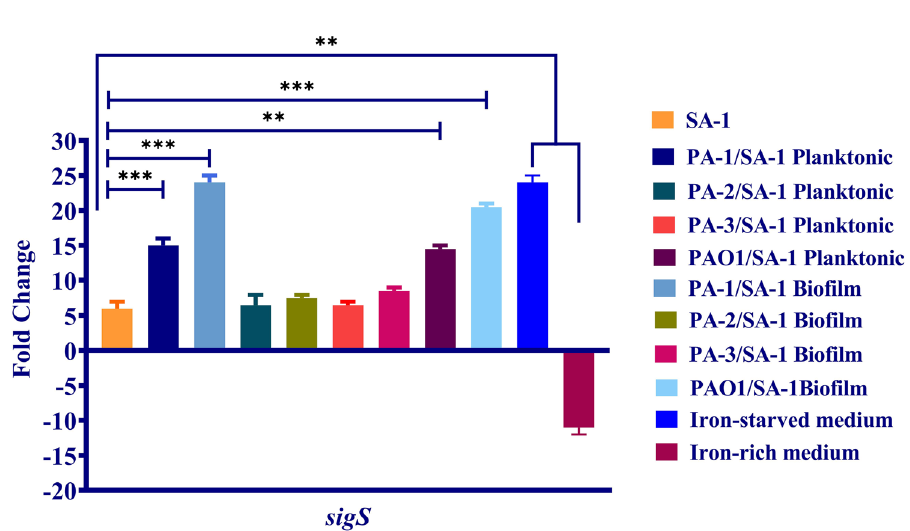
Figure 4. The expression level of ECF sigma factors of S. aureus in different states of co-culture. The changes in the sigS expression level of slow-growing phenotypes of S. aureus in the planktonic and biofilm state of co-culture compared to monoculture. Also, the expression level of sigS in the iron-rich and iron-starved medium. Each data set was analyzed using the student’s t-test, and the Holm-Sidak method for multiple comparison. The data were presented as Mean + SEM. *p-value < 0.05; **p-value < 0.01; ***p-value < 0.001; ****p-value <